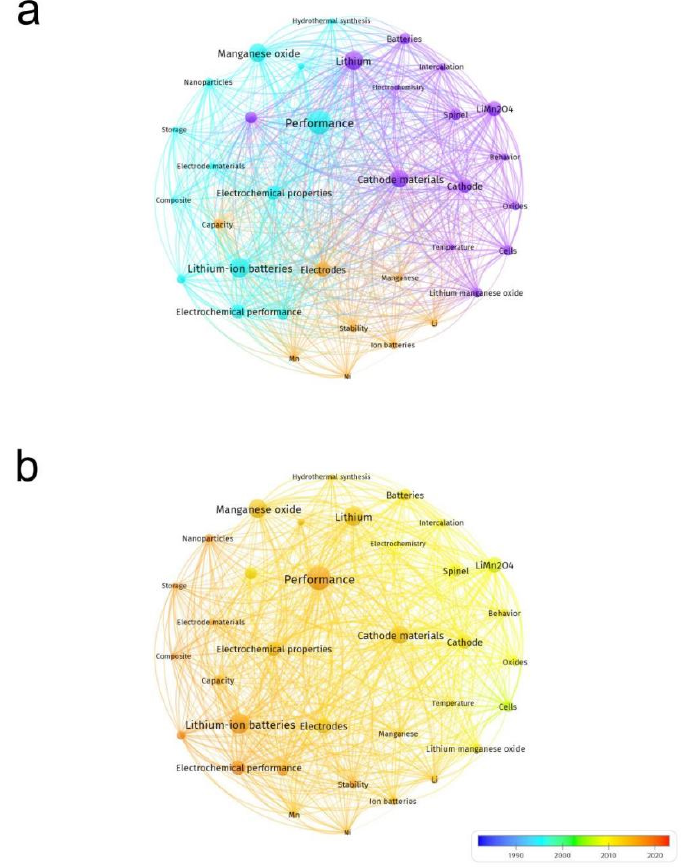
Figure 5. Waste lithium-ion battery recycling keyword contact: ( a ) keyword co-operation relationships and ( b ) keyword clustering analysis.